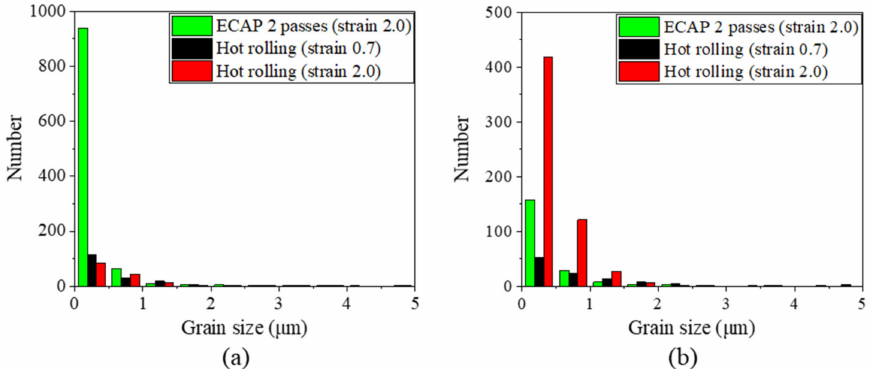
Figure 10. Grain size distribution of β -NbTi according to the initial process conditions ( a ) before and ( b ) after 1st heat